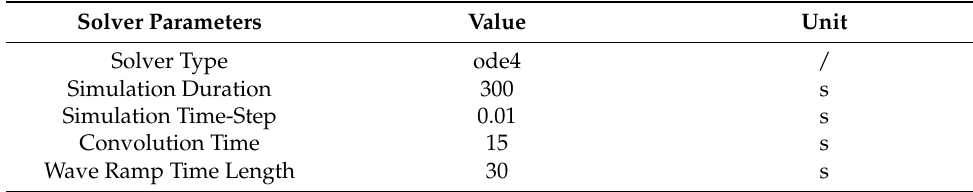
Table 5. Parameters of the